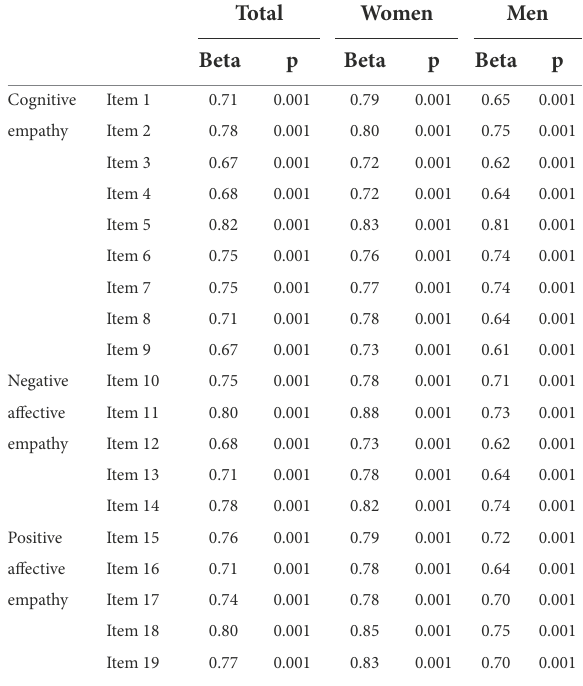
TABLE 4 Factor loadings of the scale items in the in total, female and male samples.